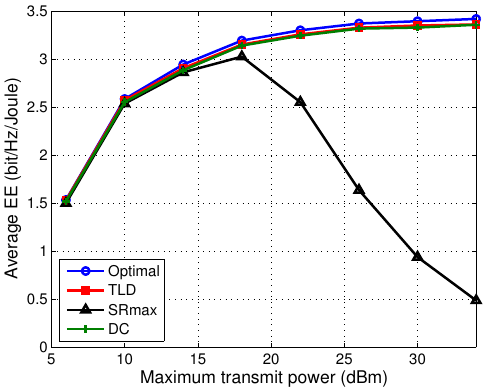
Figure 6. Average EE versus maximum transmit power with P c = 2 W and C = 5